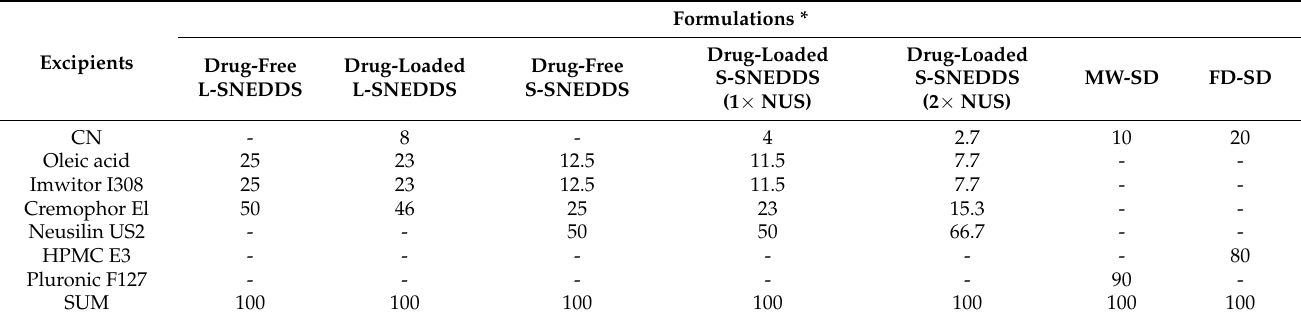
Table 1. Development of various liquid and solid formulations for CN using lipid-based excipients and inorganic silica